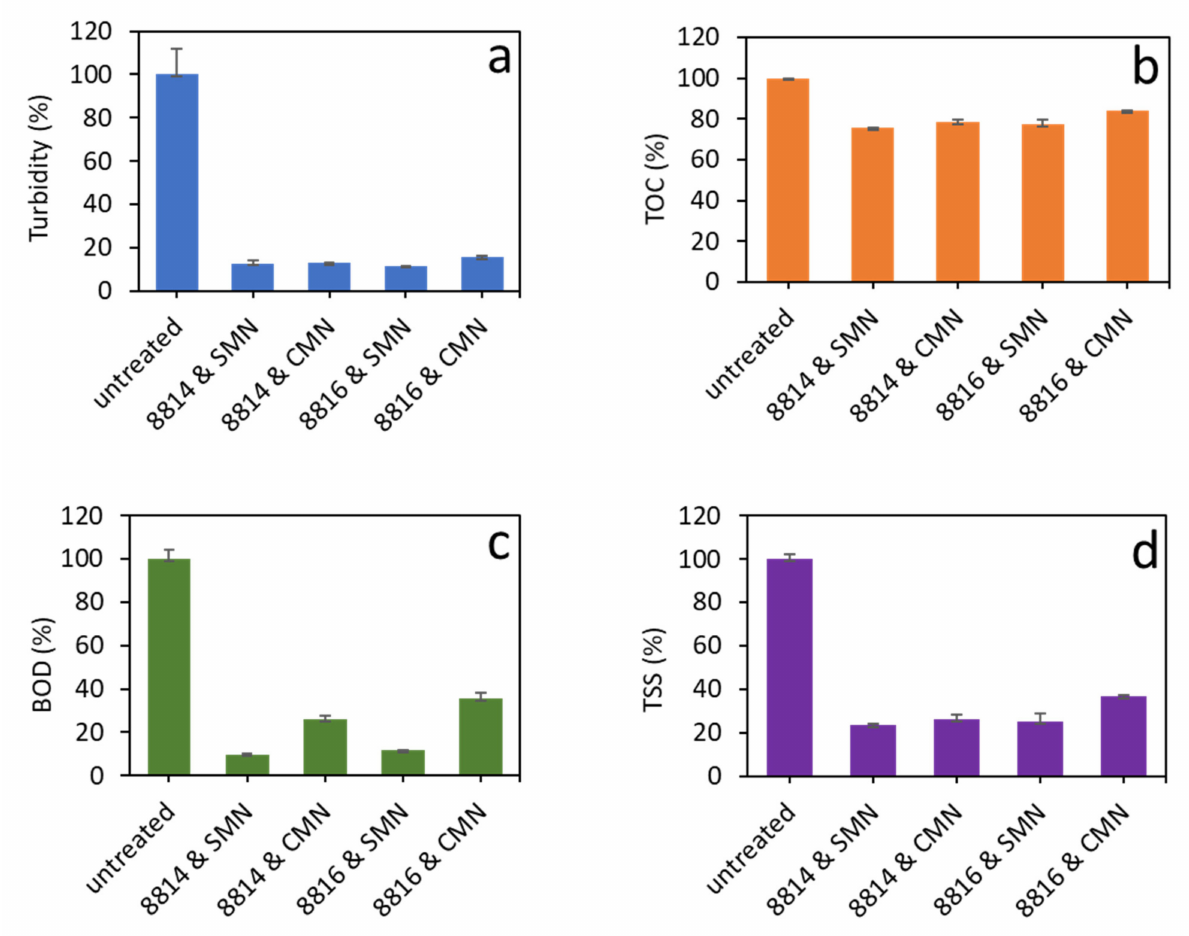
Figure 5. Additional reduction in swine water ( a ) turbidity, ( b ) TOC, ( c ) BOD, and ( d ) TSS upon MNSs